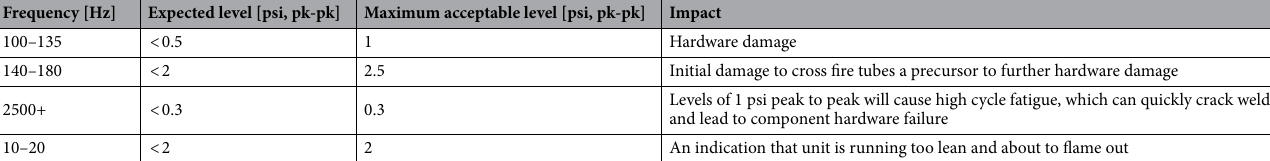
Table 2. Frequency bands of combustion instability and its dynamic response in gas turbine combustor 47